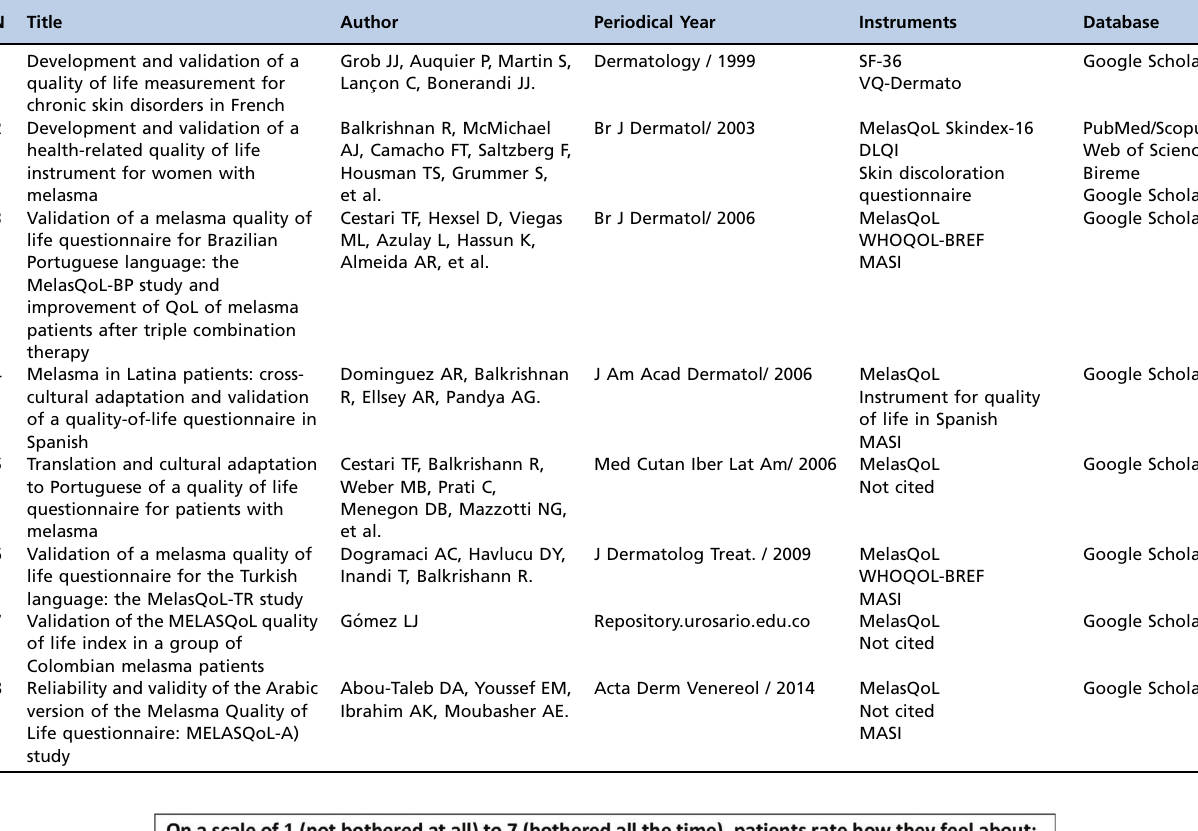
Table 1 - List of the articles included in this literature review. Botucatu, SP, Brazil, 2015.